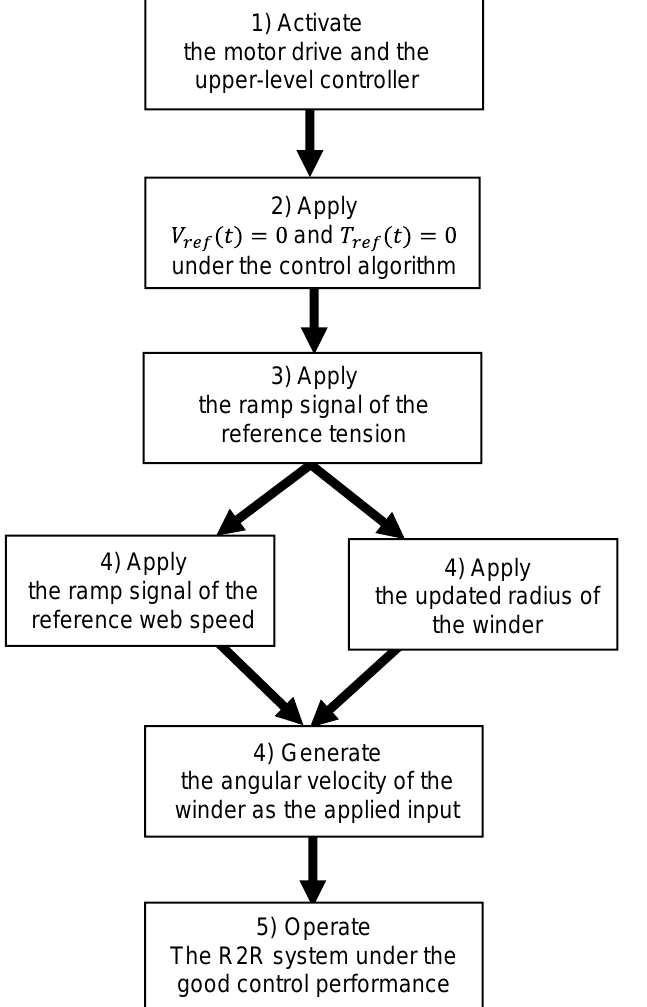
Figure 7. The entire control sequence of web handling in the longitudinal axis for the R2R